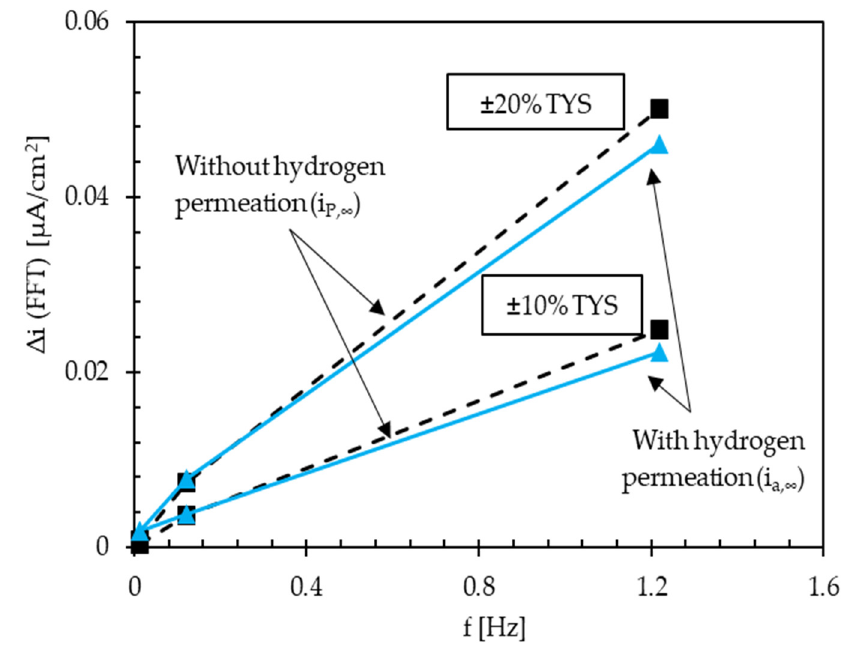
Figure 6. Current variation as a function of load amplitude and frequency, and comparison between the cases of the presence and absence of diffusible atomic hydrogen.